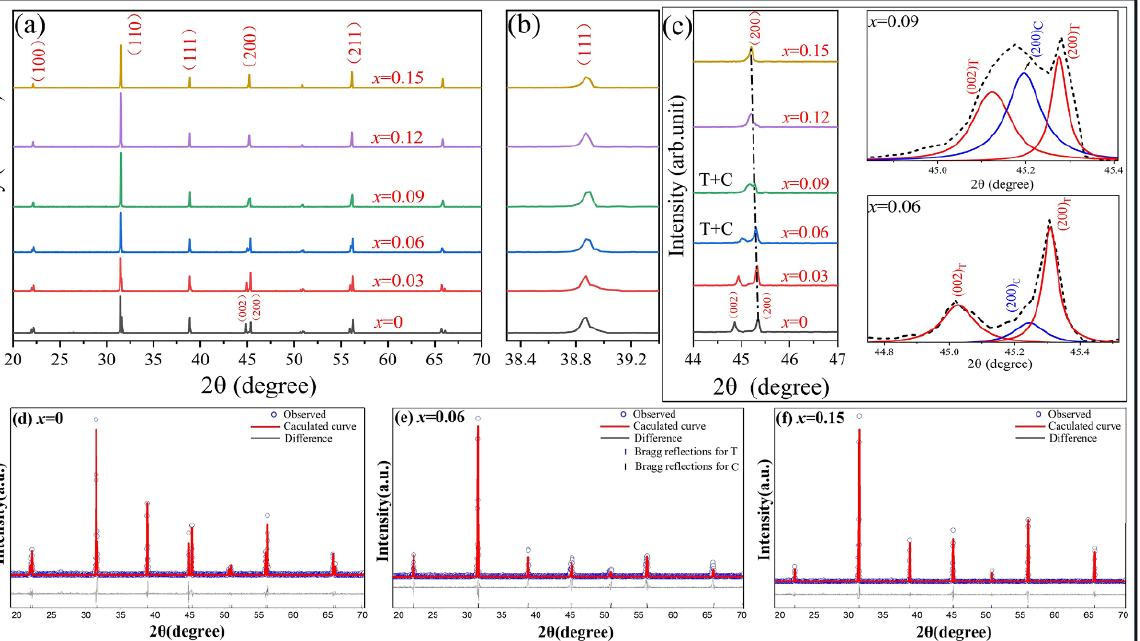
Table 1. The crystal structure and refined lattice parameters of (1 − x )BT- x CSZ ceramics. Component